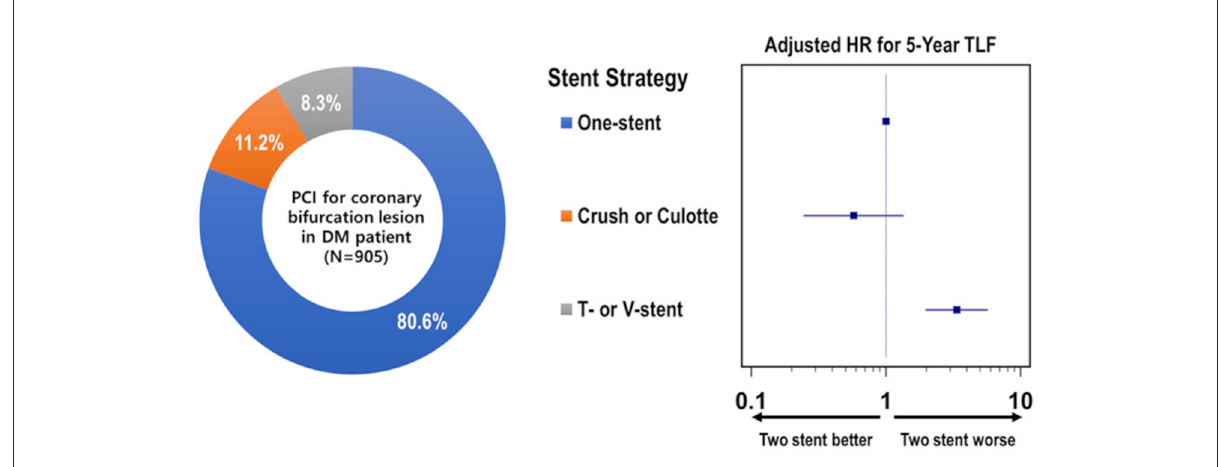
FIGURE3 Distribution and individual risk of stent strategy for coronary bifurcation lesions in patients with diabetes mellitus.